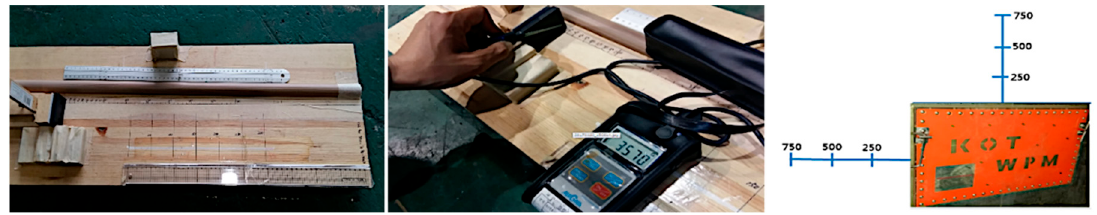
Figure 10. Magnetic field test. From left to right: fixing the magnet’s position; checking its magnetic